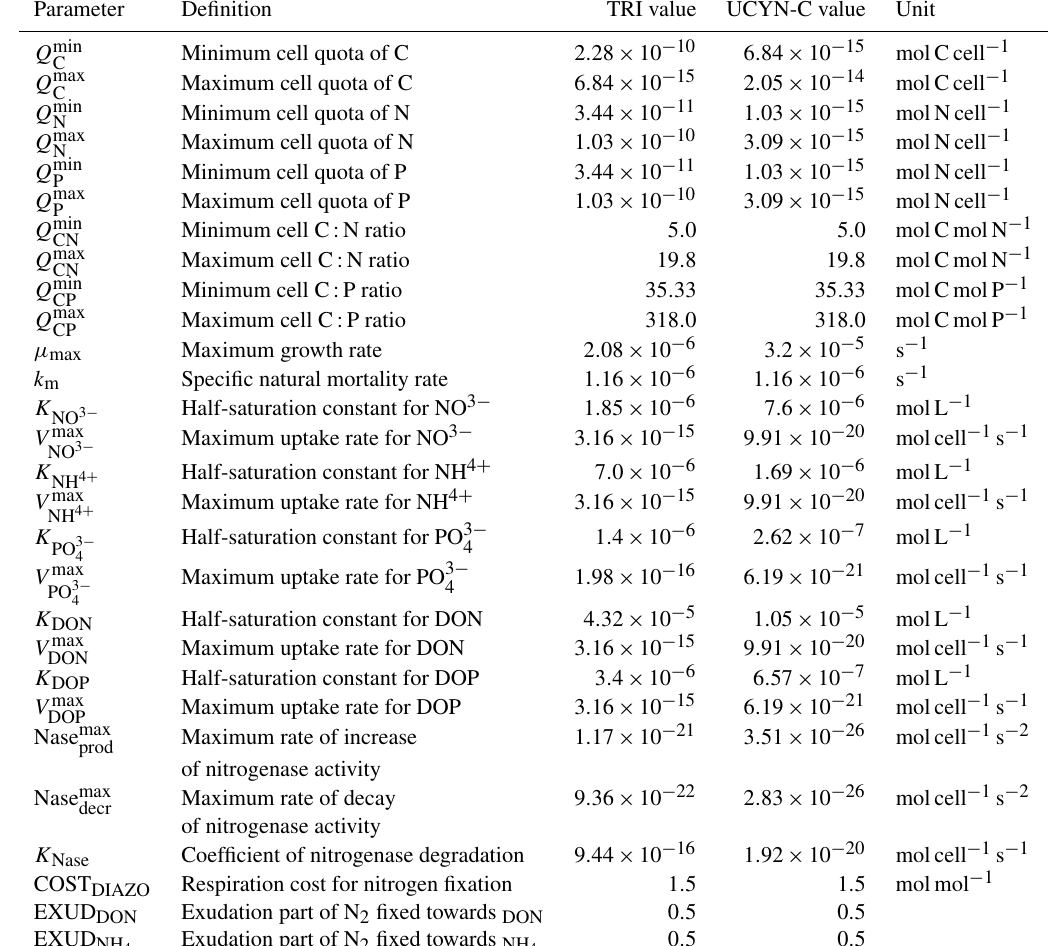
Table 2. Parameters added for the diazotroph